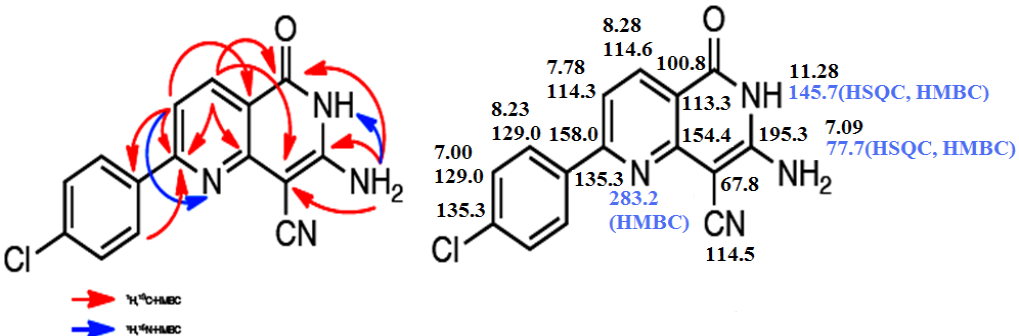
Figure 2. Upper part: ( 13 C, 1 H)- and ( 15 N, 1 H) couplings nJ (n = 2–4) according to the crosspeaks observed in the HMBC measurements of 9d . Lower part: Assignment of all 1 H, 13 C and 15 N signals of 9d . The  values obtained in CD SOCD at room temperature are related to 3 3 TMS and NH (liquid). The measurements were performed at 14.1 T (600 MHz for 1 H). 3